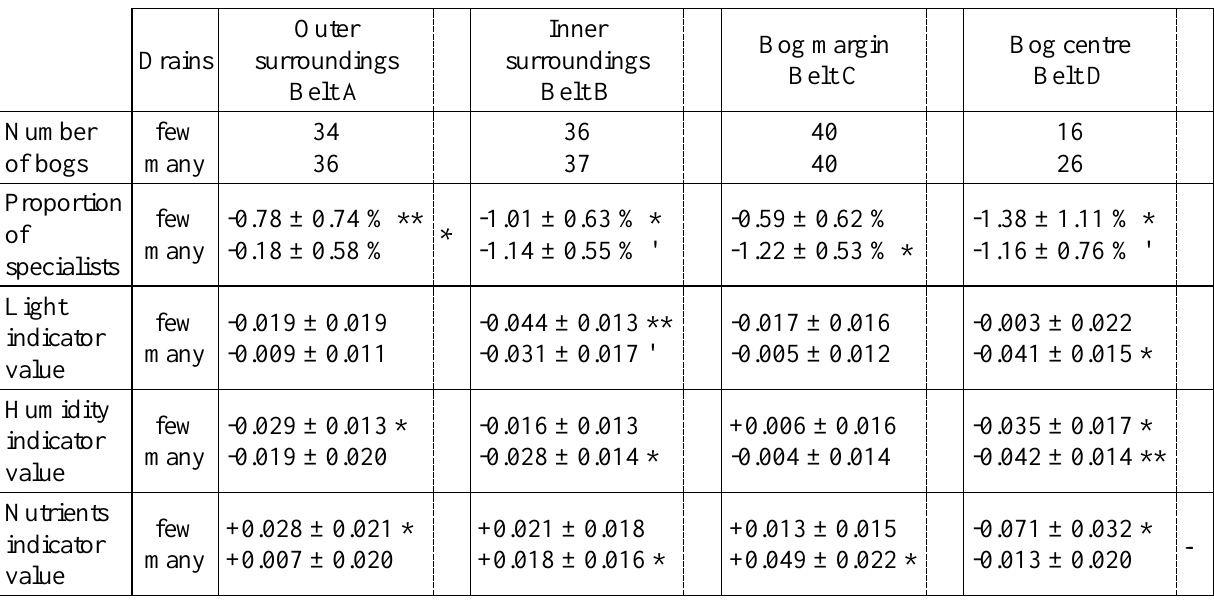
Table 9. Changes in bog quality in relation to draining structures between the first and second surveys. Changes in Belts A, B, C and D in the bogs with few and many draining structures. Significance levels for the changes themselves (signed rank sum test) and differences between bogs with few and many draining structures